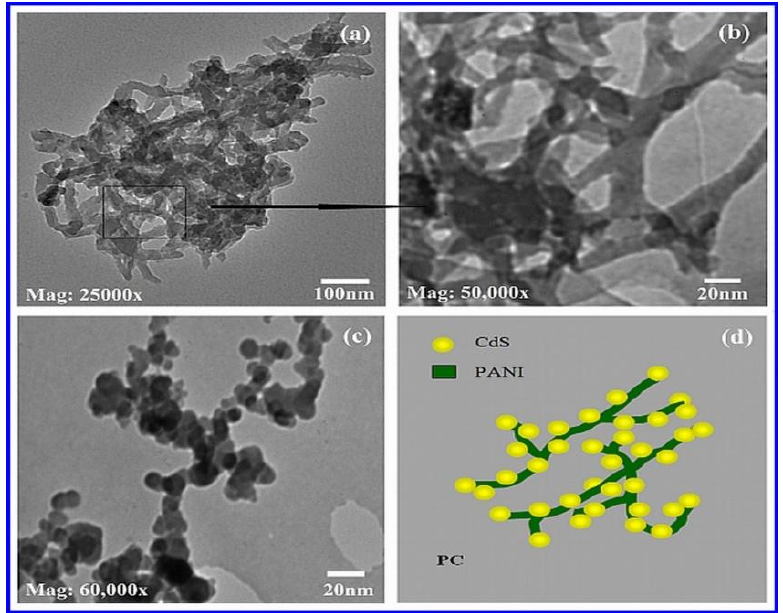
Figure 4. TEM images of ( a ) PANI at 25,000 times magnification, ( b ) PANI at 50,000 times magnification, ( c ) PC at 60,000 times magnification and ( d ) representative diagram of PC.